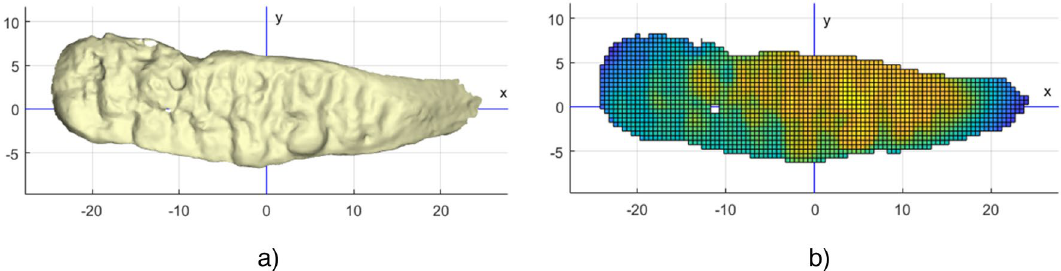
Figure 2. Top view on the articulation surface of the pubic symphysis. ( a ) Irregular triangulation-based surface (triangle edges are not shown); ( b ) articulation surface approximated over regular mesh (individual “pixels” are coloured according to the actual z-value). The actual grid size used for the SASS method is set to 0.1 mm, which is five times smaller compared to this illustration. This provides sufficient resolution for further processing.